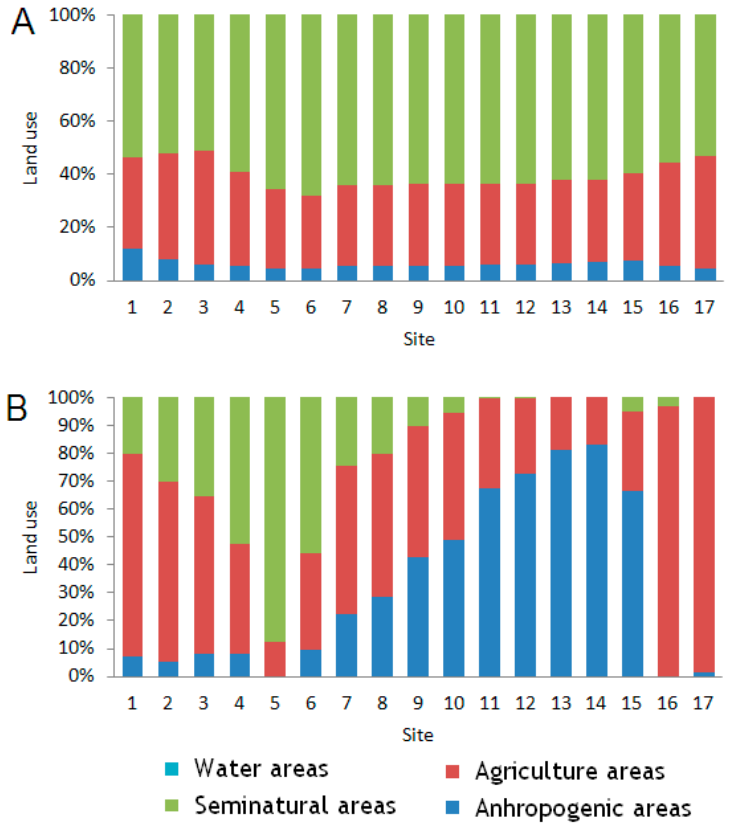
Figure 3. Percentage land use in catchment area of the Corgo river in examined sites. ( A ) Total catchment area. ( B ) Buffer zone of 1 km of catchment area, 2 km upstream.